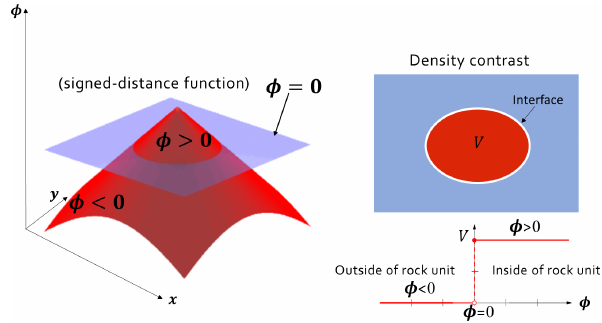
Figure A1. Illustration of the signed-distance function for density contrast of a single rock unit. Modified from https://en.wikipedia. org/wiki/Signed_distance_function (last access: 16 October 2021).